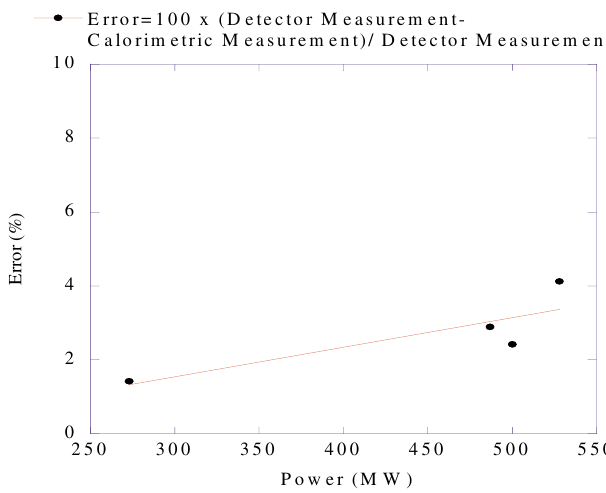
FIG. 25. (Color) Discrepancy between readings of the peak power analyzer connected to the dual-mode directional coupler at the output and calorimetric measurements on the cooling water of the loads. The peak power analyzer signal was inte- grated to get average power for comparison.